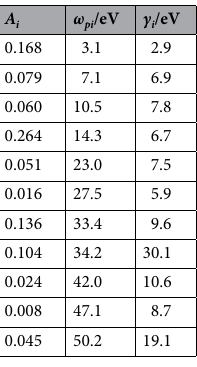
Table 1. Parameters used to determine bulk ELF of Eq. (2) in the energy loss range up to 60